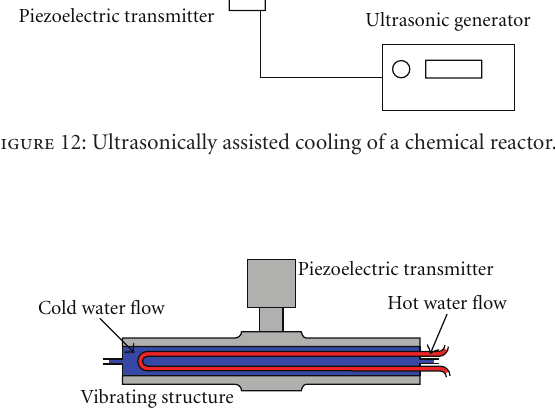
Figure 13: Schematic diagram of the vibrating shell and tube heat